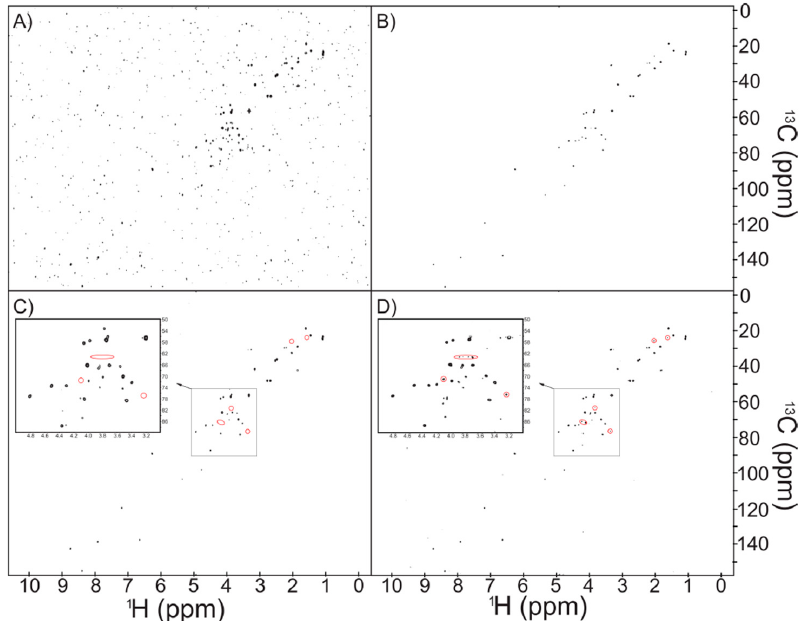
Figure 1. Non-uniform sampling (NUS) increases sensitivity and resolution compared to uniform sampling (US). US ( A ) and NUS ( B ) spectra for Reference 1 when the maximum peak intensity of each spectra is normalized to 10. US ( C ) and NUS ( D ) spectra for Reference 1 at the same contour level. Red circles indicate resonances only detected in the NUS spectrum.